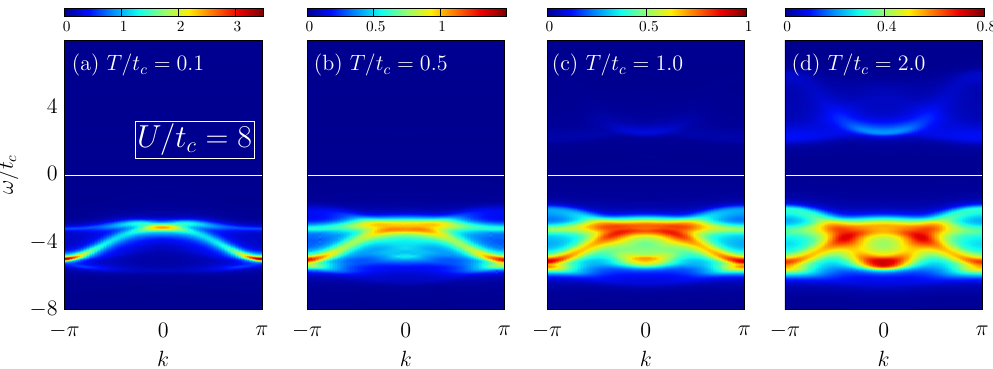
Figure 4: Photoemission spectra A − ( k , ω ) in the 1D half-filled EFKM at finite tem- peratures. Model parameters are t = 256. L W